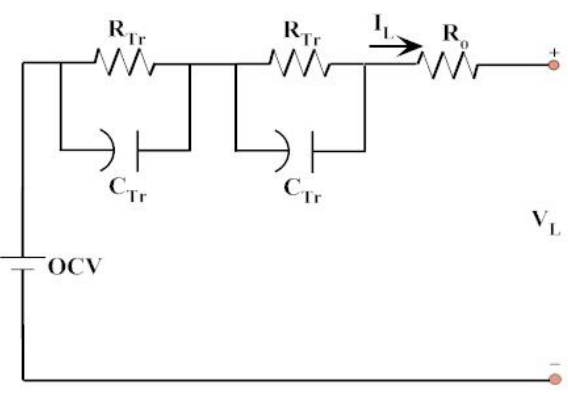
Figure 8. Second order battery model.